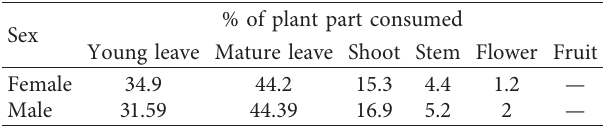
Table 3: Percentage of plant parts consumed by male and female klipspringers.